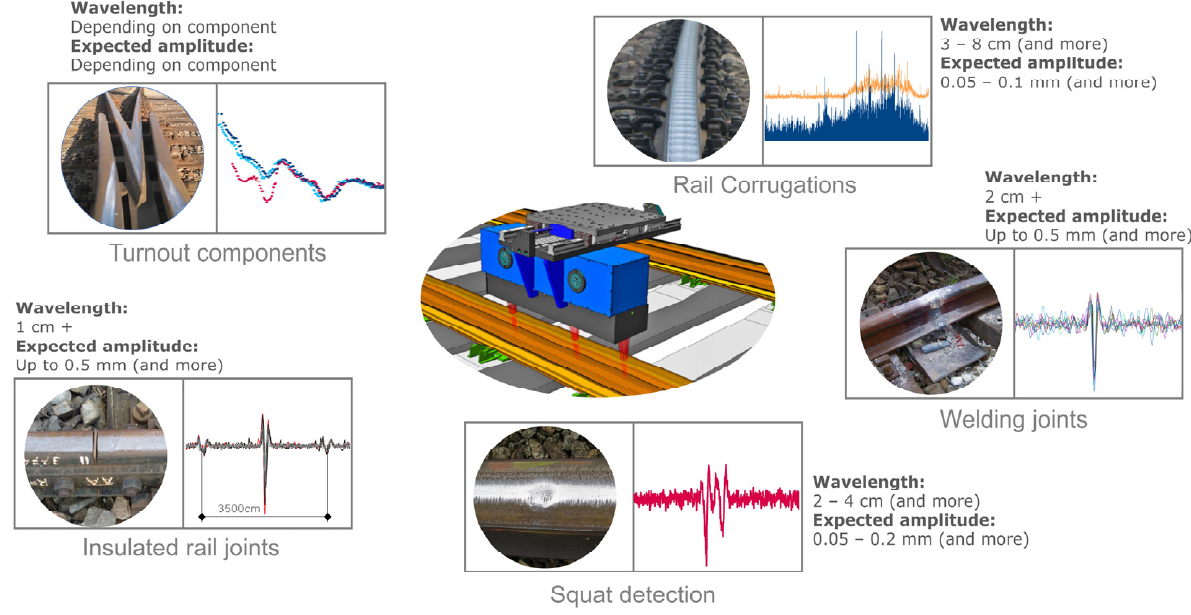
Figure 3. Potentials of the rail surface signal Figure 3 . Potentials of the rail surface signal [22].